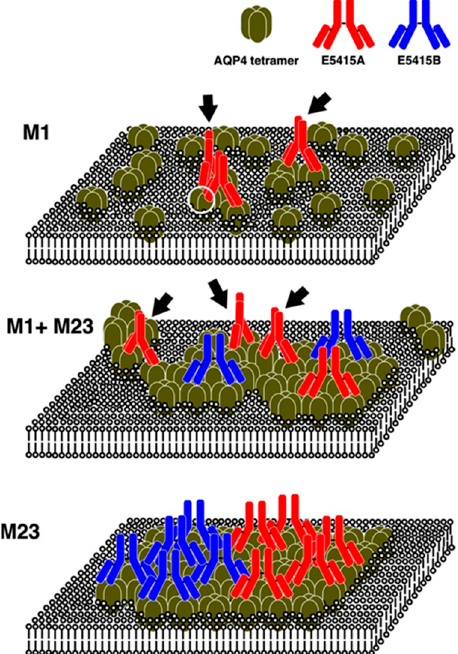
Figure 2. Schematic illustrations of putative binding of E5415A and E5415B against AQP4 on the plasma membrane. E5415A and E5415B are represented in red and blue, respectively. E5415A molecules binding to AQP4 tetramers, which are not incorporated into OAPs, are indicated with arrows. An AQP4 tetramer binding to two E5415A molecules is indicated with a white